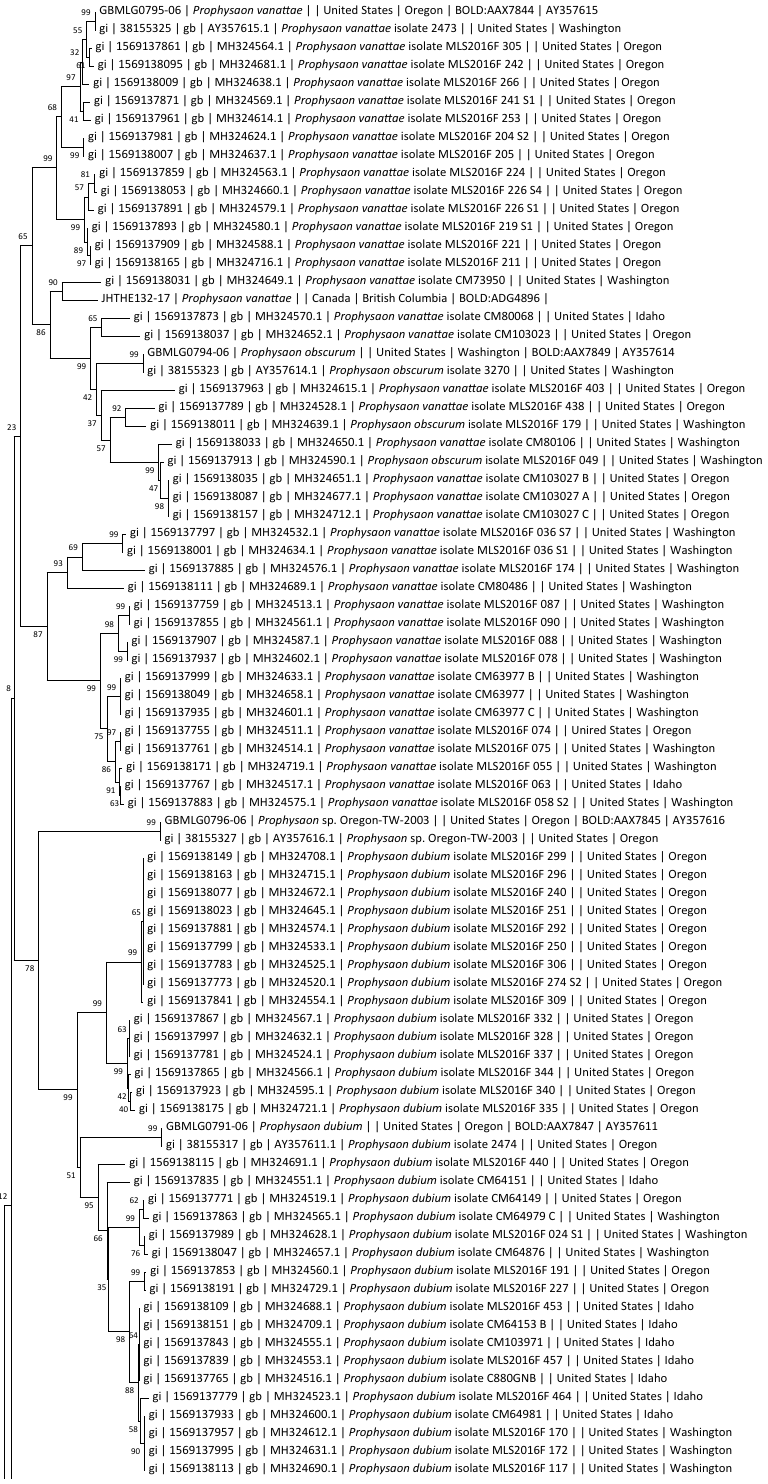
Figure 3. Evolutionary relationship of Prophysaon species. Indicated at each branch are from left to right: record code | species name as identified | Barcode of Life Data Systems sample ID | country | province or state | Barcode Index Number | Genbank accession number. The single shortest tree with the sum of branch length = 3,19852518 is shown. The percentage of replicate trees in which the associated taxa clustered together in the bootstrap test (1000 replicates) are shown next to the branches (Felsenstein 1985). The tree is drawn to scale, with branch lengths in the same units as those of the evolutionary distances used to infer the phylogenetic tree. (Figure continued on next